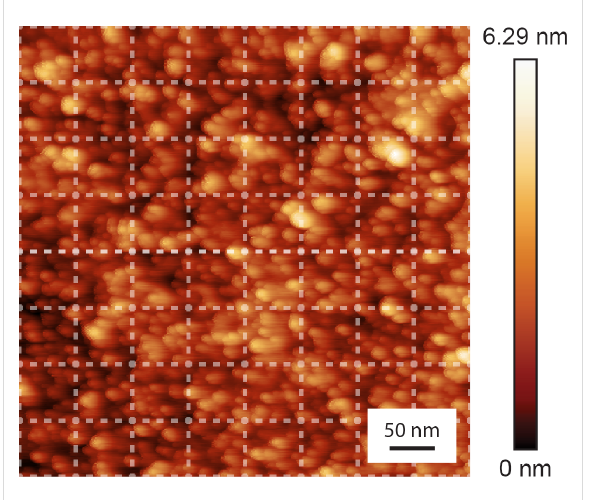
Figure 3: Topographic AFM image of the diamond surface showing the nanometer-scale roughness of the surface. Dashed lines show the grid on which the Δ f – d curves were